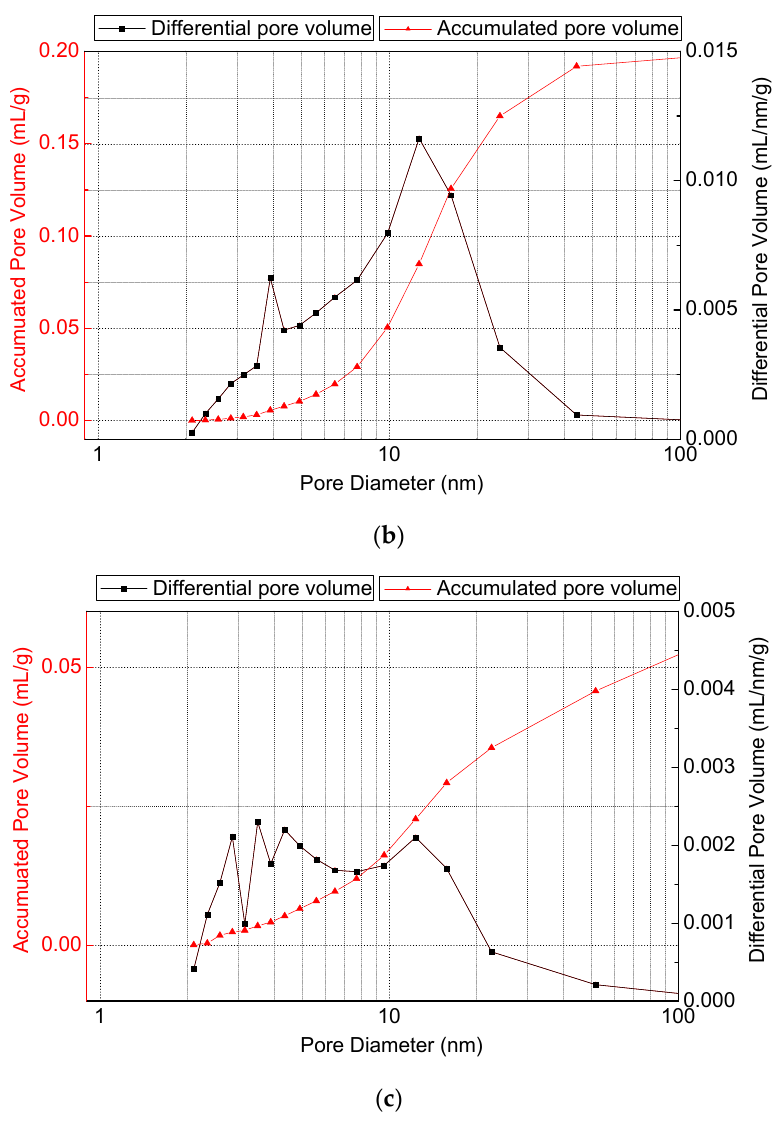
Figure 4. The pore-size distribution curves of pre-calcined sample #1 at 800 °C, 1000 °C, and 1200 °C for 2 h. ( a ) 800 °C, 2 h ( b ) 1000 °C, 2 h ( c ) 1200 °C, 2 h.